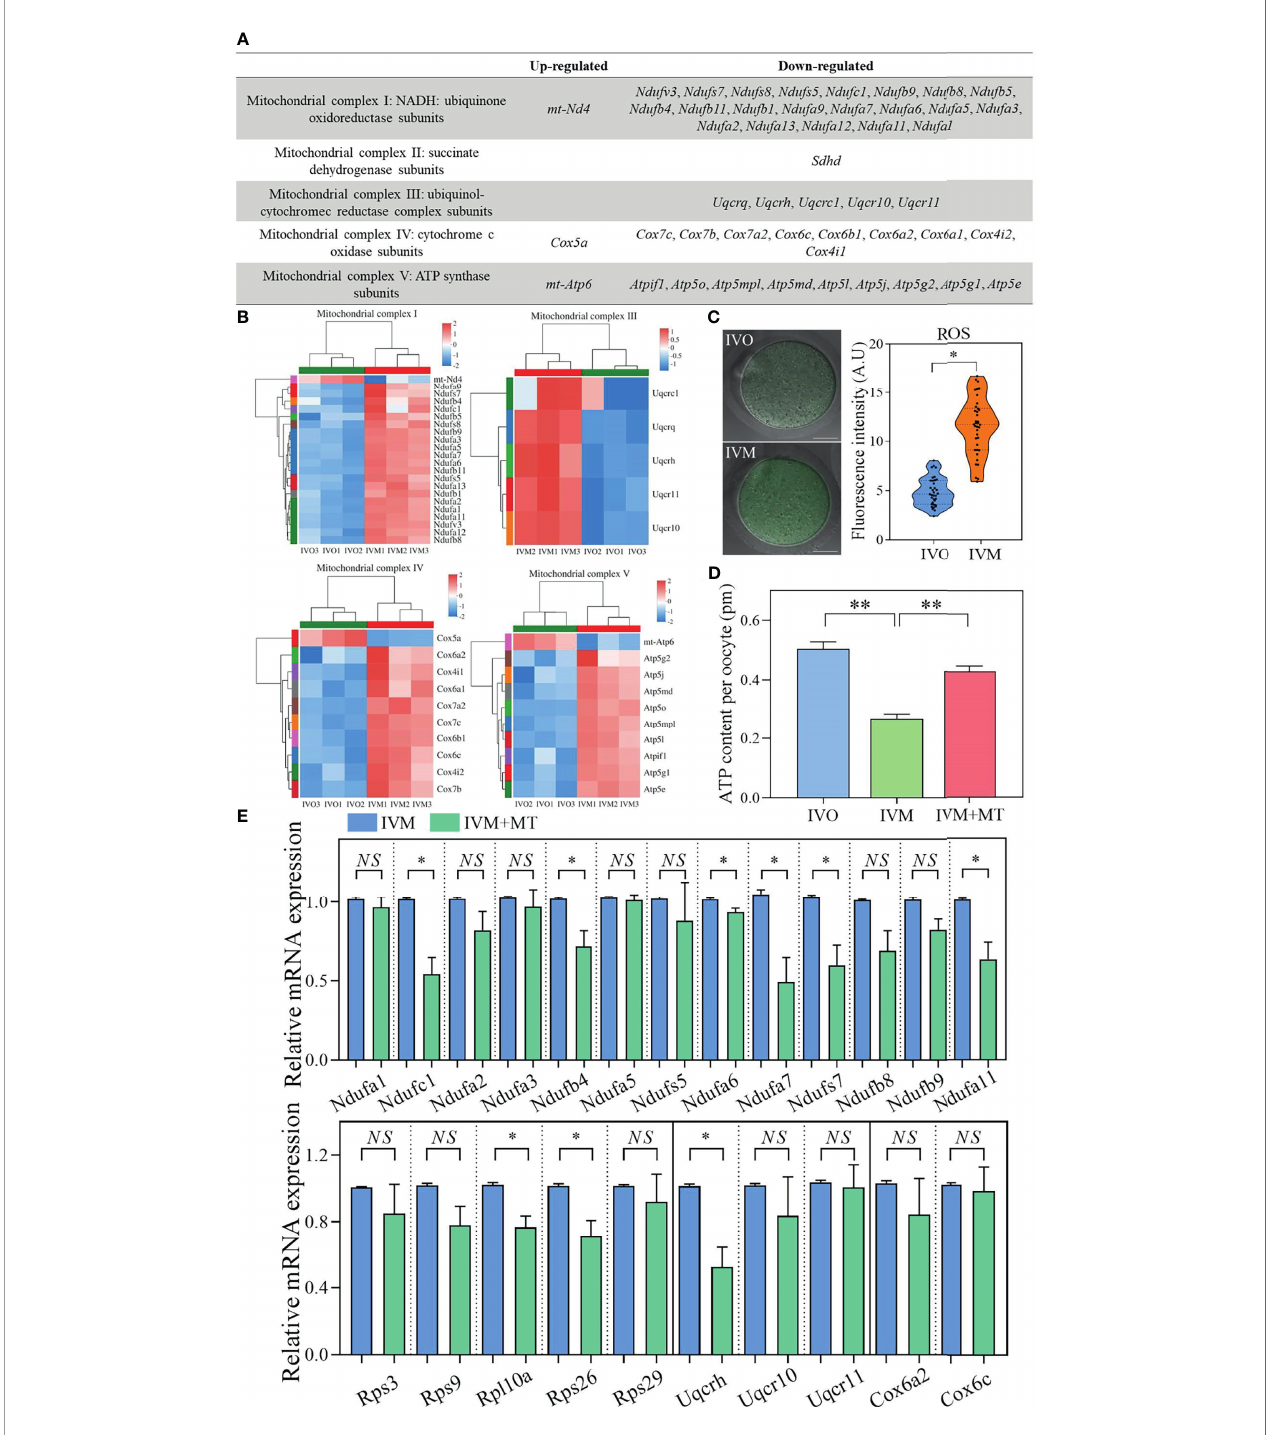
FIGURE 4 | (A) List of up- and down-regulated genes in the OXPHOS system of fi ve respiratory chain complexes in the mitochondria when compared between IVO and IVM groups. (B) Heatmaps corresponding to the identi fi ed DEGs. The red rows represent high expression levels and the blue rows represent low expression levels. Each column represents an independent sample. (C) Representative images of ROS signals in IVO and IVM groups. Scale bars = 20 m m. The fl uorescence intensity of ROS in IVO and IVM groups. (D) Graphs showing the ATP levels in IVO, IVM, and melatonin-treated IVM oocytes ( n =20 for each group). (E) The relative mRNA levels of target genes including NADH-ubiquinone oxidoreductase (complex I) subunits, the ribosomal protein family, ubiquinol-cytochrome c reductase subunits, and cytochrome c oxidase subunits between the IVM and melatonin-treated IVM oocytes. Data represent the mean ± SEM of three independent experiments. NS , not signi fi cant, * P < 0.05, and ** P <